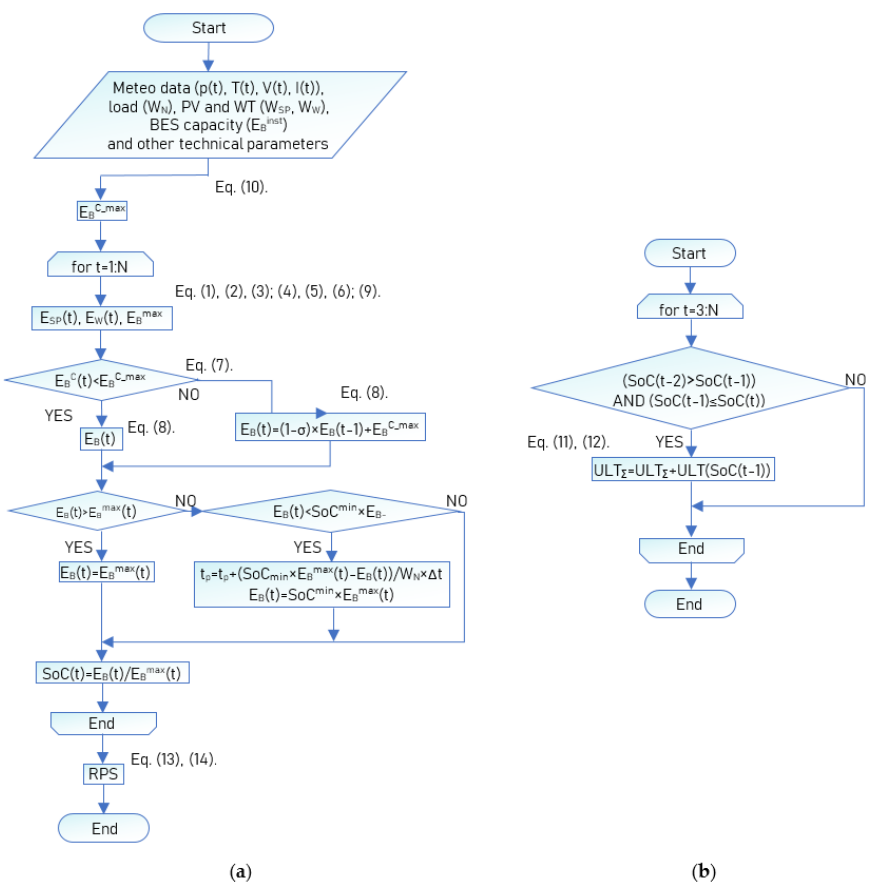
Figure 2. Calculation algorithms of the ( a ) RPS and ( b ) ULT Σ where SoC min is the minimum allowable SoC. As a result of such calculation, LD also could be obtained.